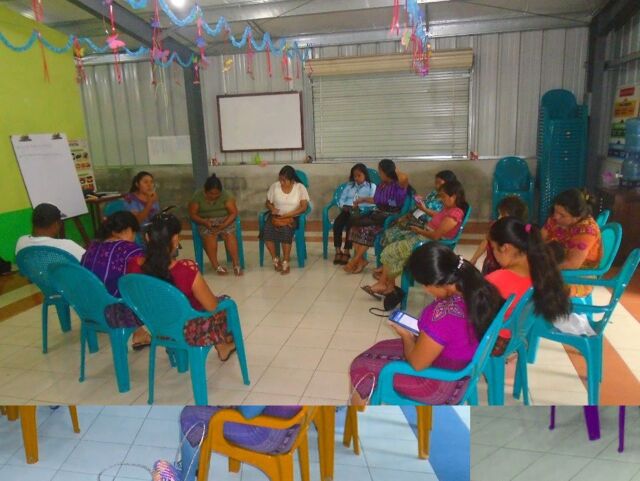
Community health workers in Guatemala practice using a smartphone application for diabetes care.Credit: © 2018 José Vicente Macario/San Lucas Mission